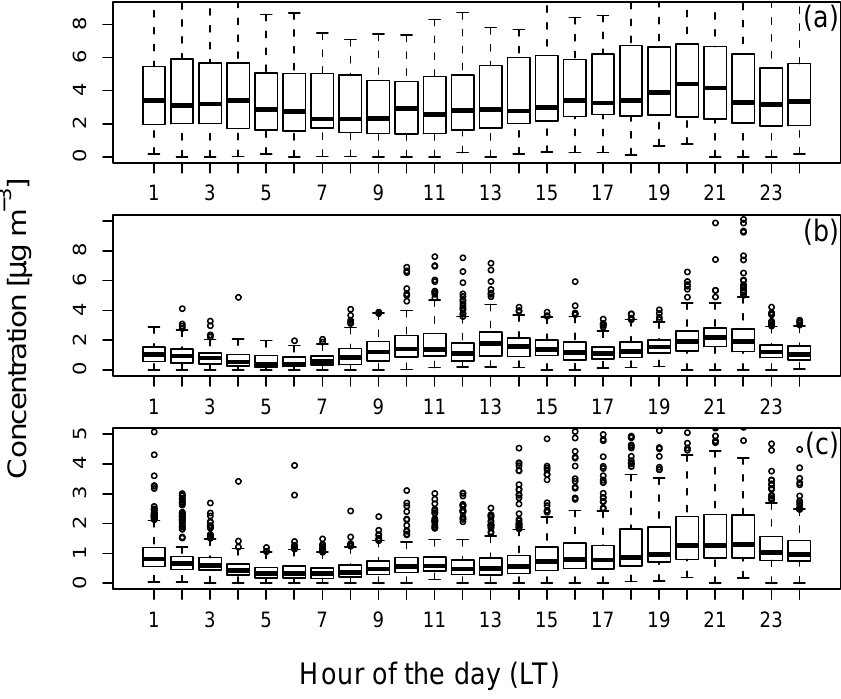
Fig. 13. Average diurnal variations of the OOA (a) , HOA (b) , and BBOA (c) factors from the AMS-PMF analysis. (Fig. 11) with Pearson correlation coefficients R in the range of 0.5–0.6. The correlations are shown for the